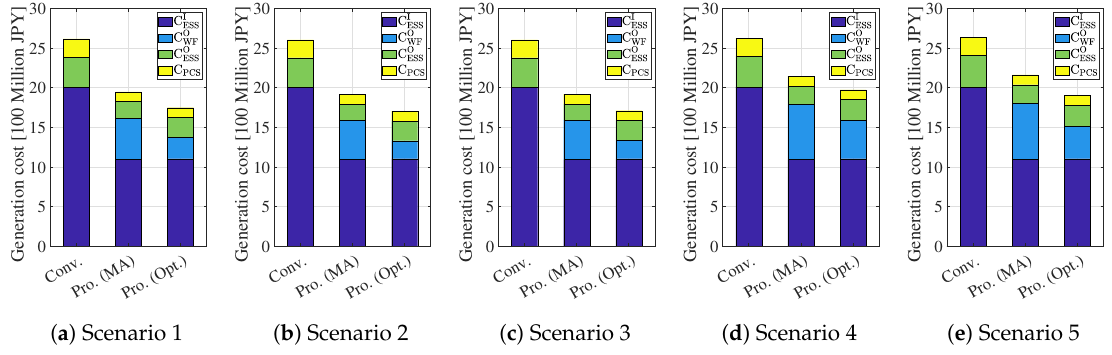
Figure 17. Cost (NaS